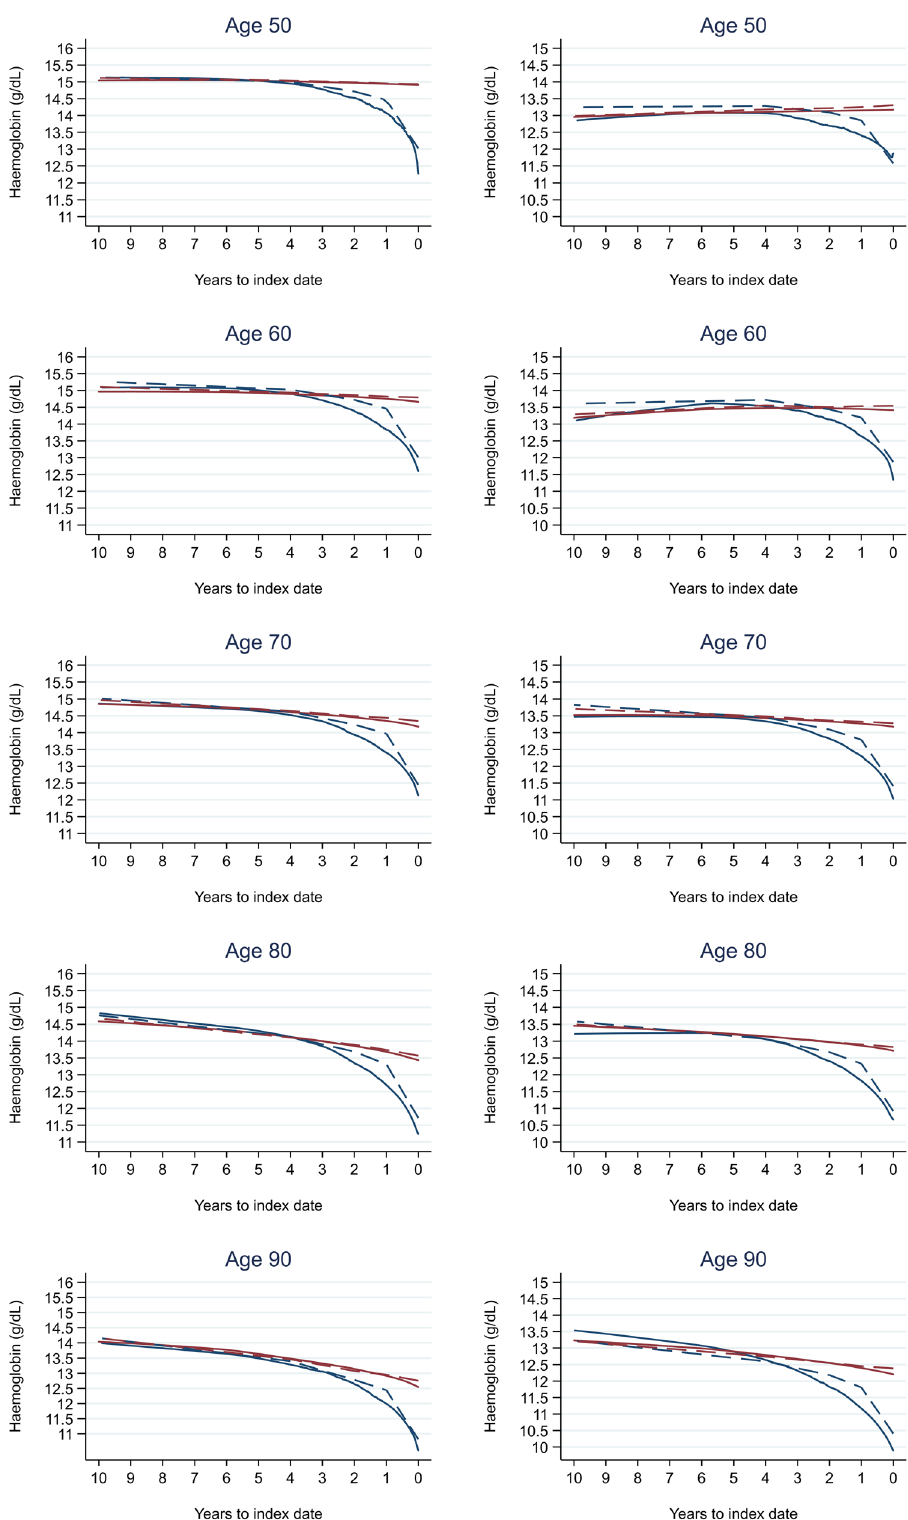
Figure 5. Haemoglobin trends between cases and controls, by age at index date 1,2 . 1 Index date was the date of diagnosis for cases and a randomly selected date in the patient’s study period for controls. 2 LOWESS trends are age (+/- 3 years) and modelled (fixed effects) trends are taken at that specific age. Legend: males (left) and females (right). Colorectal cancer (blue line) and no cancer (red line). LOWESS trend (solid line) and modelled trend (dashed line).